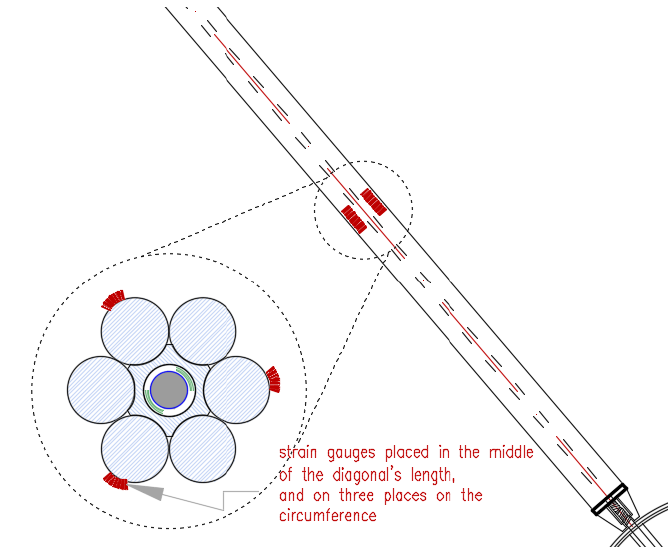
Fig. 26 strain gauges placement on glass diagonals of the